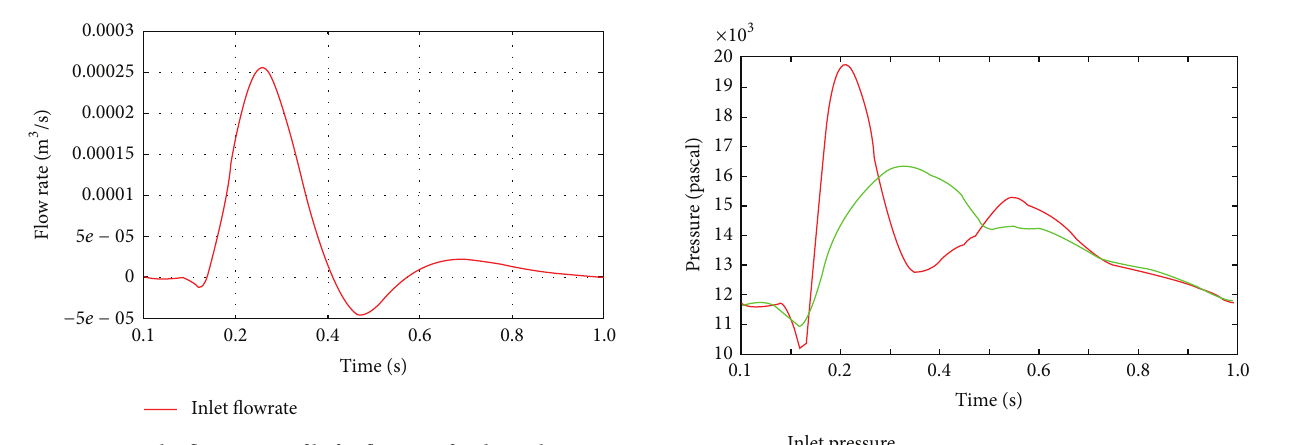
Figure 2: Inlet flow rate profile for flow rate fixed simulation.